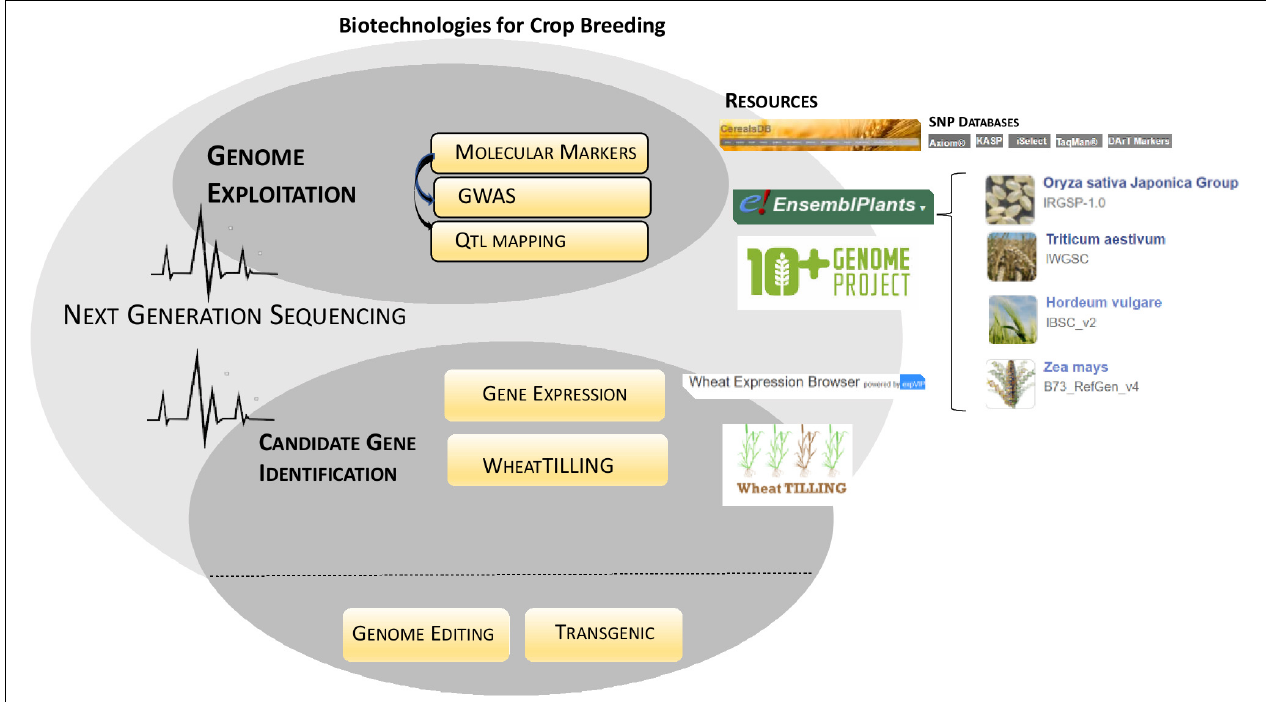
FIGURE 4 | Biotechnologies for crop breeding. The figure summarizes the role played by advanced biotechnologies in crop breeding indicating novel resources now available (Resources). NGS has accelerated both genome exploitation and candidate gene identification by boosting molecular markers research (GWAS/QTL mapping) and transcriptomic/genetic variability studies,